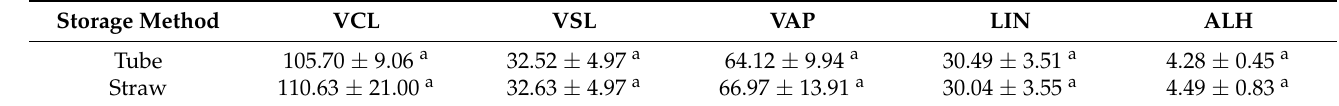
Table 1. Effects of storage methods (tubes of 15 mL or 0.25 mL straws) during refrigeration of Iberian red deer epididymal spermatozoa on kinematics parameters. Data represented as mean ± SEM. VCL—curvilinear velocity ( µ m/s); VSL—rectilinear velocity ( µ m/s); VAP—velocity for the corrected trajectory ( µ m/s); LIN—linearity (%); ALH—lateral head displacement ( µ m). Same letter within columns indicate not significant differences ( p ≥ 0.05).